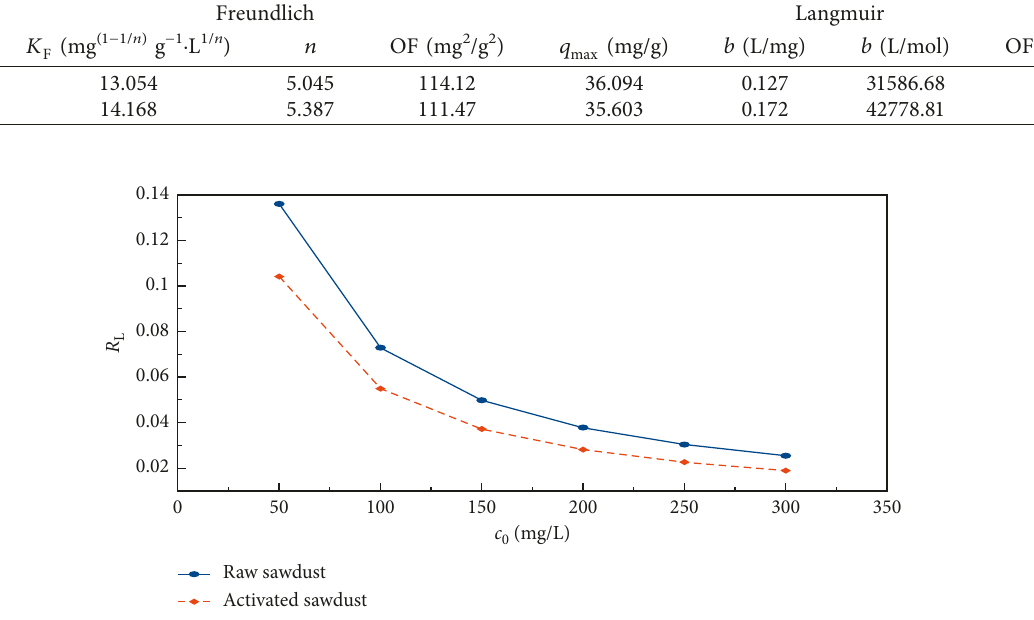
Figure 9: Effect of initial concentration on the Langmuir adsorption factor of raw and activated saw